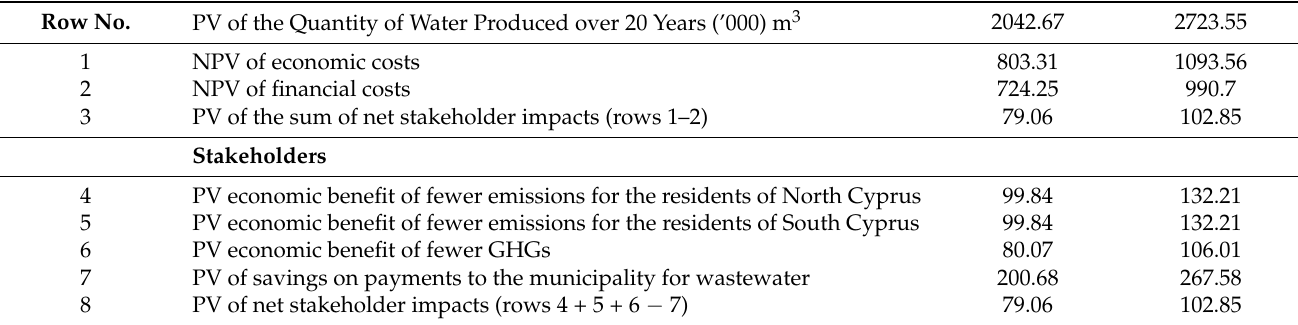
Table 16. Stakeholder analysis of the investment to upgrade the RO plant, in 2022 prices (’000)